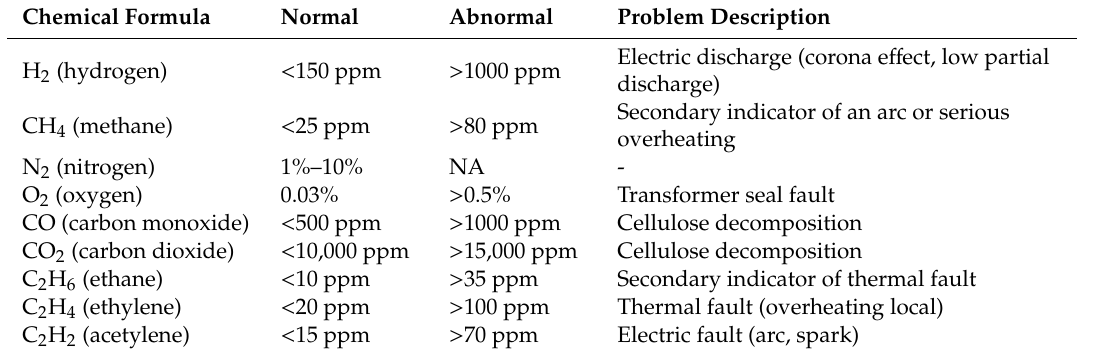
Table 1. Fault description for gas concentration.